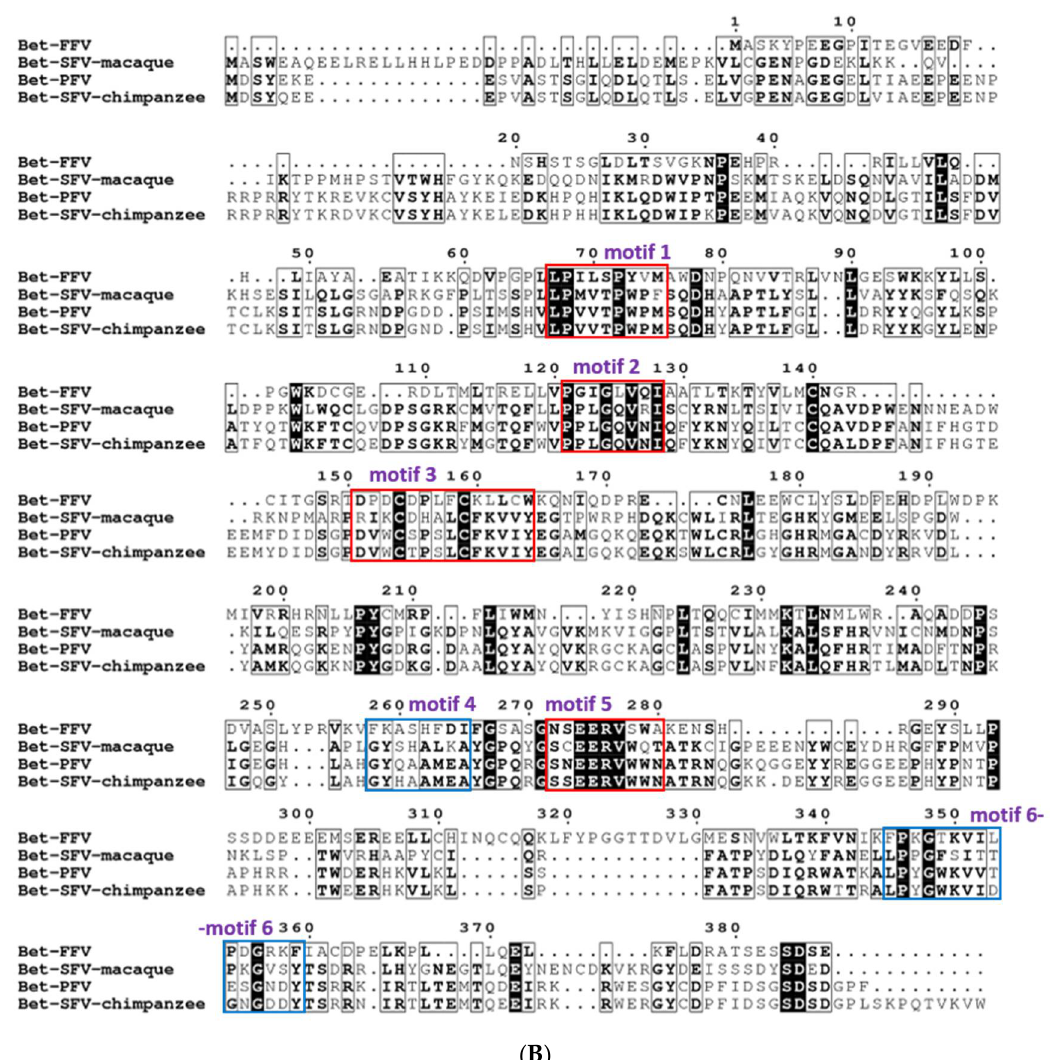
Figure 2. The diversity of Bet proteins. ( A ) Phylogeny of FV Bet amino acid sequences. A neighbor-joining tree based on Bet protein sequences was calculated by using the Maximum Composite Likelihood method with a bootstrap test of 10,000 replicates. Bet from BFV, FFV, SFVs (from gorilla, chimpanzee, macaque, Japanese macaque, AGM, and Guenon); HIV-1 Vif served as the out-group. Bar, 10% sequence variation. Accession numbers are provided for each sequence in the bracket. Note that we could not include Bet from other exogenous and endogenous FVs due to the lack of sequence description. ( B ) Multiple sequence alignment of Bet from FFV, PFV, and SFVs. Amino acid sequence identity and similarity among these Bet proteins are 6.7% and 64%, respectively. Additional sequence alignment leaving FFV Bet exhibited 32% identity and 79% similarity of primate FV Bet sequence (alignment not shown). Sequence alignment was performed by Clustal Omega (http://www.ebi.ac.uk/Tools/msa/clustalo/, accessed on 6 December 2020). The alignment file was then submitted to ESPript 3.0 [204] (espript.ibcp.fr) to calculate the similarity and identity of residues between these proteins and to represent the multiple sequence alignment. Six conserved motifs in Bet sequences are marked by boxes, from which four red-colored motifs were experimentally studied due to high sequence conservation, as reported before [89].